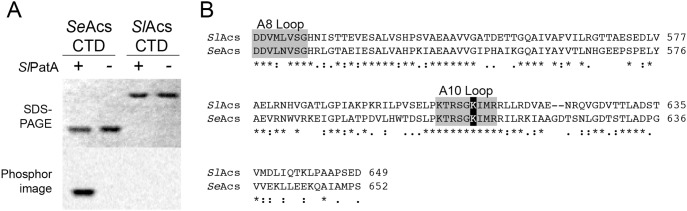

SlPatA efficiently acetylates the C-terminal domain of SeAcs.A. The C-terminal domain of SlAcsWT or SeAcsWT was incubated with [1-14C]-acetyl-CoA in the presence or absence of SlPatAWT. Proteins were separated by SDS-PAGE and stained with Coomassie Blue R to visualize proteins. Acetylation was visualized by phosphor imaging. B. Alignment of the C-terminal domain of SlAcs and SeAcs. “ * ” denotes conserved residues; “.” denotes similar residues; light gray boxes denote conserved loops of the AMP-forming CoA ligase family [39]; dark gray box denotes catalytic lysine.